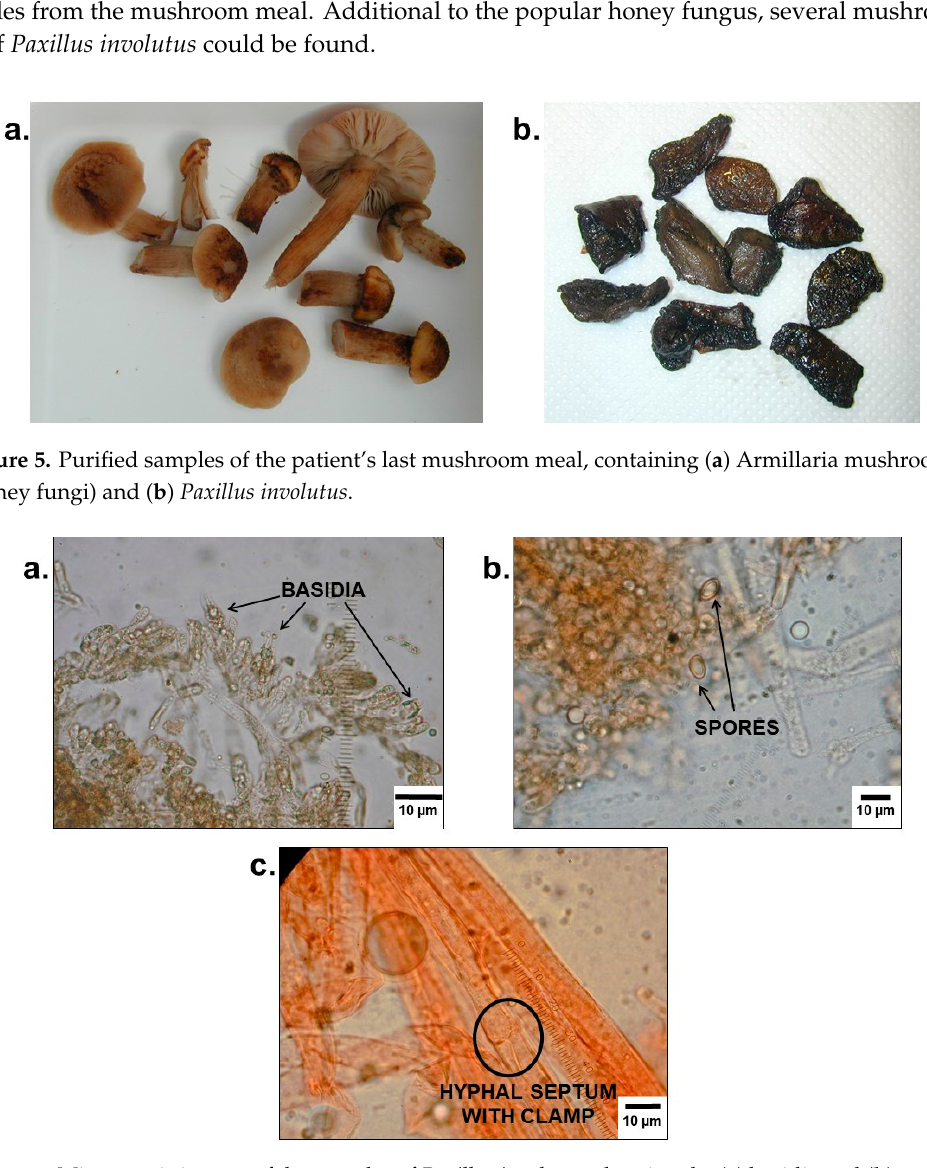
Figure 6. Microscopic images of the samples of Paxillus involutus , showing the ( a ) basidia and ( b ) spores in water, as well as a ( c ) hyphal septum with clamp connection in Congo red.